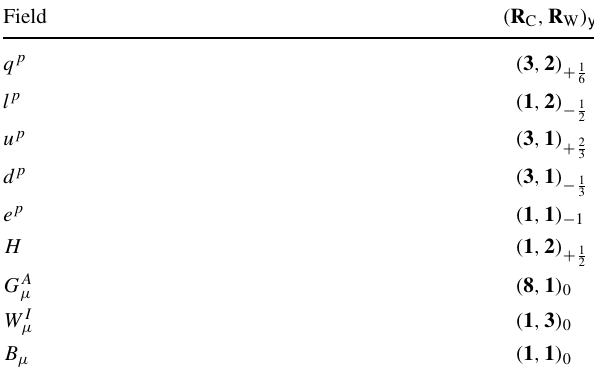
Table 1 SU ( 3 ) C ⊗ SU ( 2 ) W ⊗ U ( 1 ) Y quantum numbers of SM fields. p is a flavour index